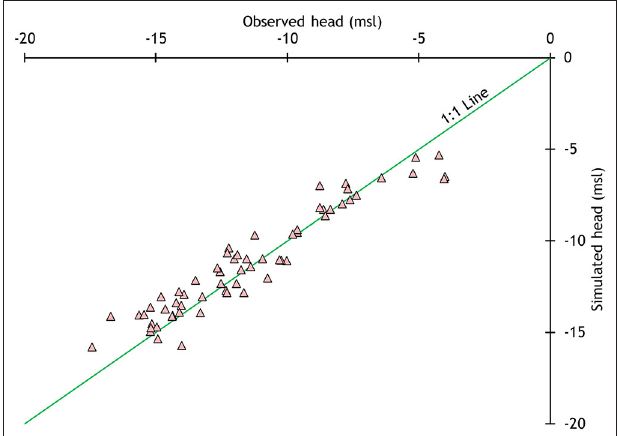
FIGURE 3 | Cross-plots of simulated head with observed head of 2016